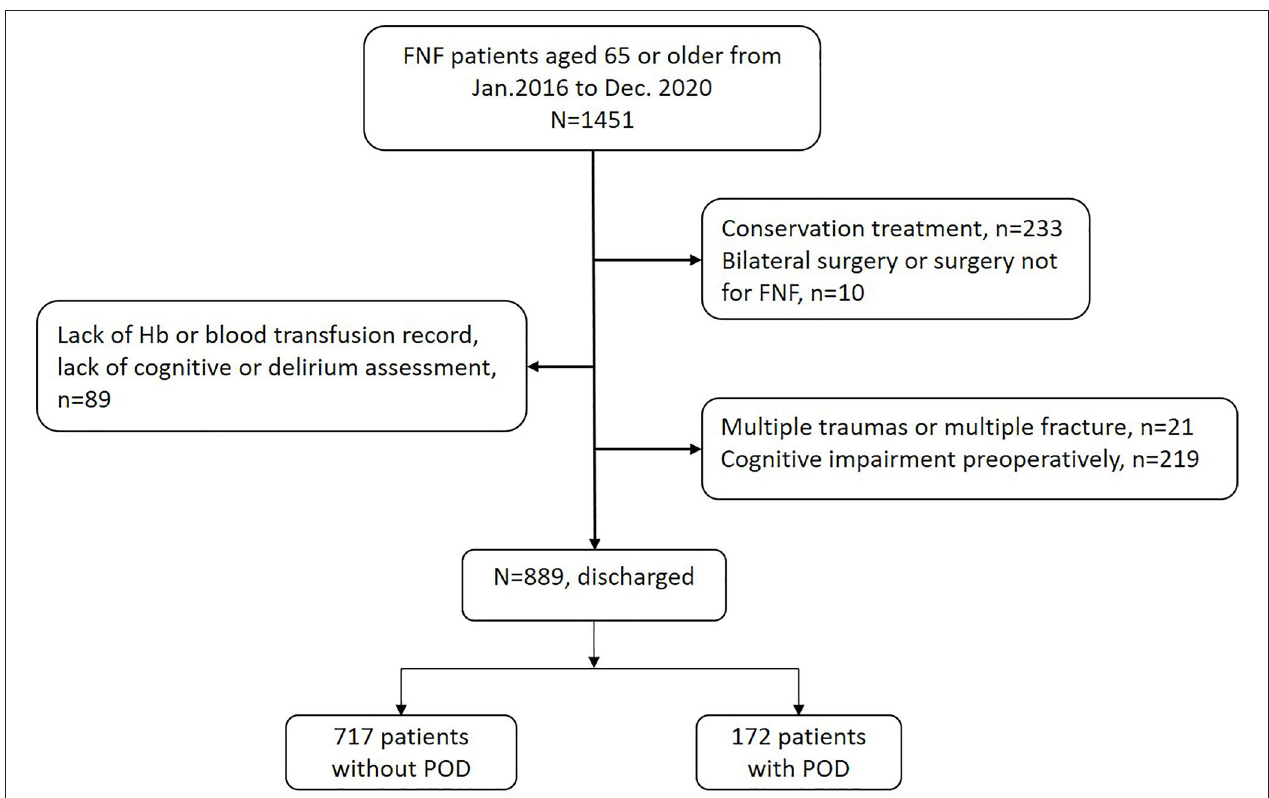
FIGURE 1 | Flowchart of the case selection. FNF, femur neck fracture; Hb,